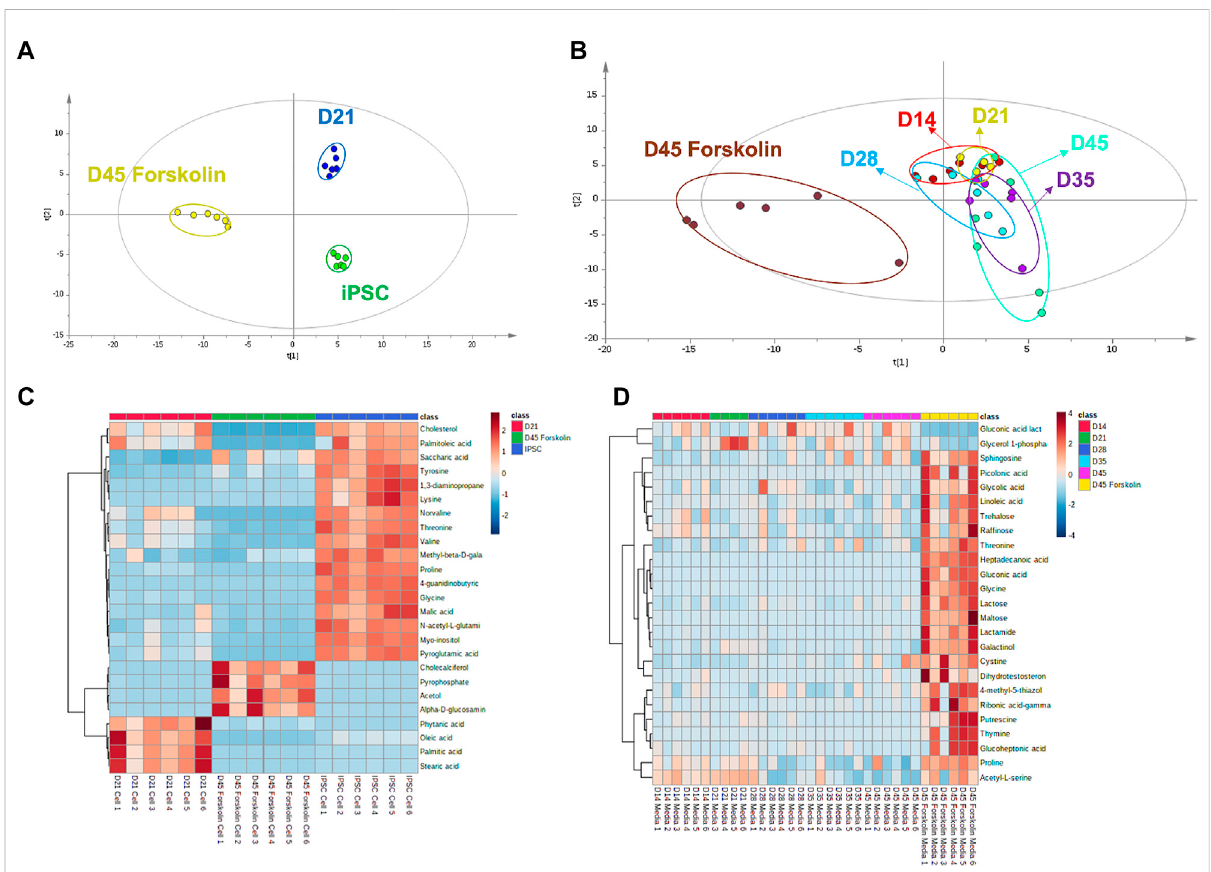
FIGURE 7 Metabolomic analysis of cell and culture medium (A) PLS-DA score plot for metabolomic pro fi les of cell lines at different time points and presenceofthestimulant( R 2 =.820andQ 2 :.978) (B) PLS-DAscoreplotforexometabolomicpro fi lesofcellculturemediums( R 2 =.410andQ 2 :.117) (C) Heat map for cell metabolites (D) Heat map for cell culture medium metabolites (n = 6 biological